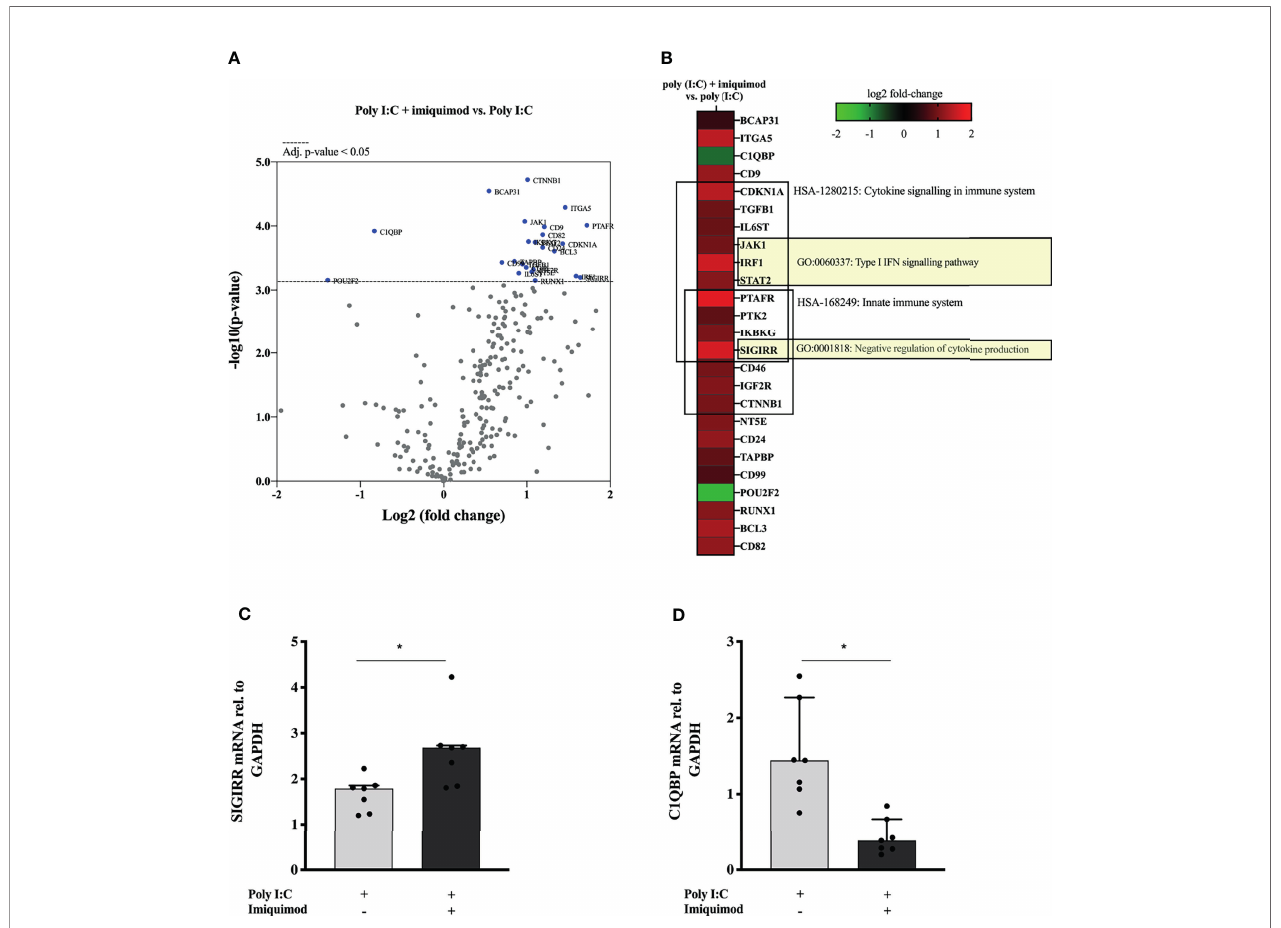
FIGURE 6 | Imiquimod induces the upregulation of multiple anti-viral gene expression pathways in human bronchial epithelial cells (HBECs) exposed to the viral replication mimic poly(I:C). (A) Volcano plot showing differentially expressed genes between poly(I:C) + imiquimod treated versus poly(I:C)-stimulated HBECs, N = 3. Multiple t-test analyses with the corrected method of Benjamini and Yekutieli were used. An adjusted p-value < 0.05 was considered signi fi cant. (B) Heat map representation of the 25 most down-regulated and up-regulated genes in response to imiquimod treatment. The most relevant overrepresented Gene Ontology (GO) terms are depicted. N = 3. SIGIRR (C) and C1QBP (D) mRNA expression in HBECs from asthmatic subject (N = 7) in response to poly(I:C) or in combination with imiquimod. Wilcoxon matched-pairs signed rank test for comparisons between two different treatment conditions. *p < 0.05.